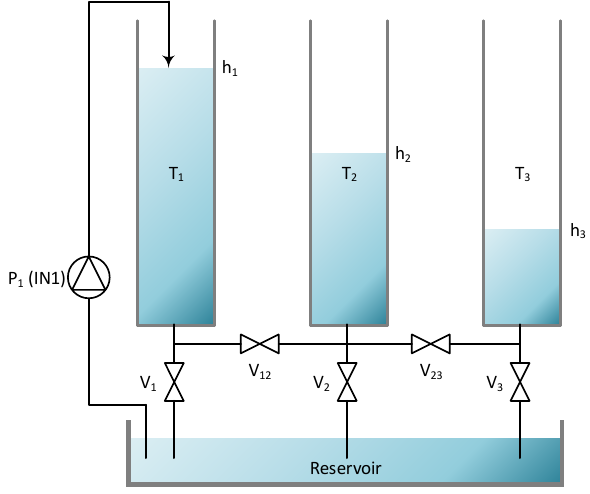
Figure 20. Schematic diagram of hydraulic laboratory setup.